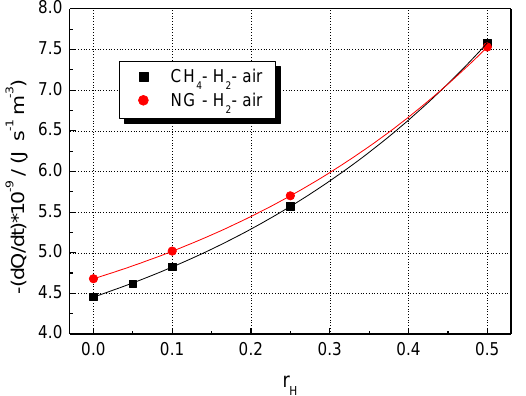
Figure 9. Influence of hydrogen fraction, r H , on peak values of volumetric rates of heat release in the flame front of H 2 -blended fuels; flames of stoichiometric mixtures at ambient p 0 and T 0 .